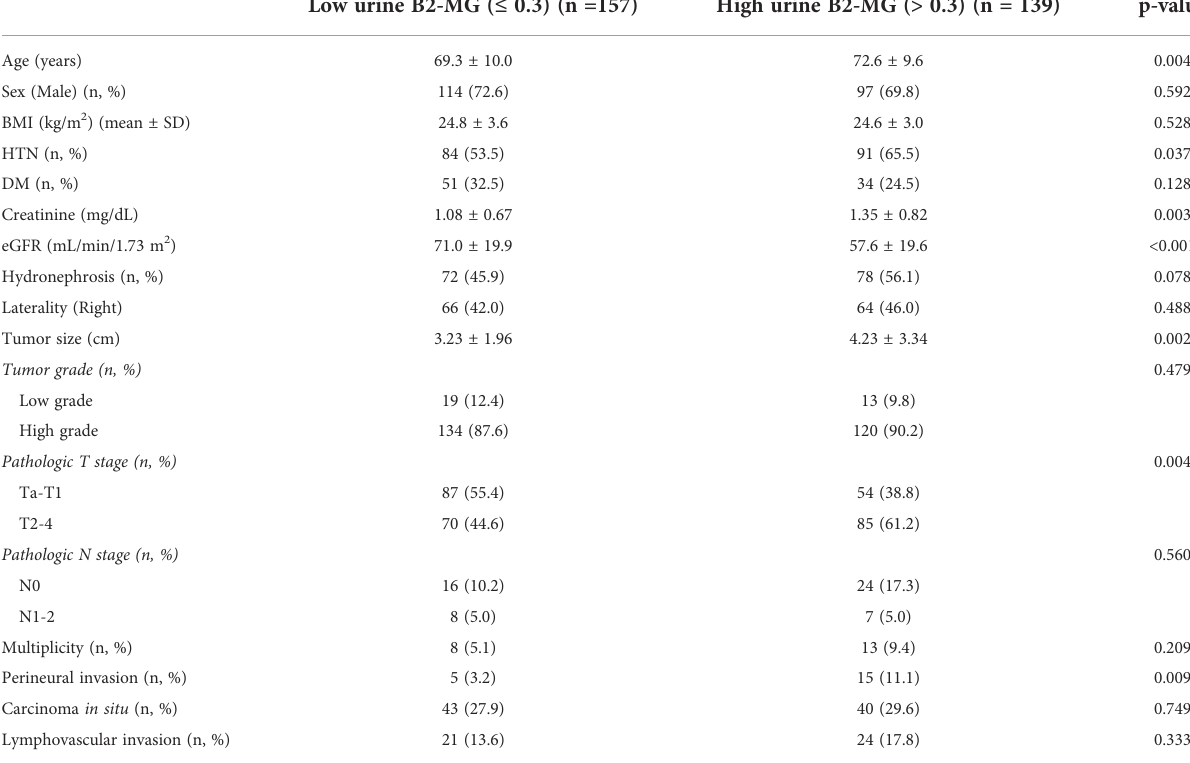
TABLE 3 Comparison of low and high urine B2-MG groups.